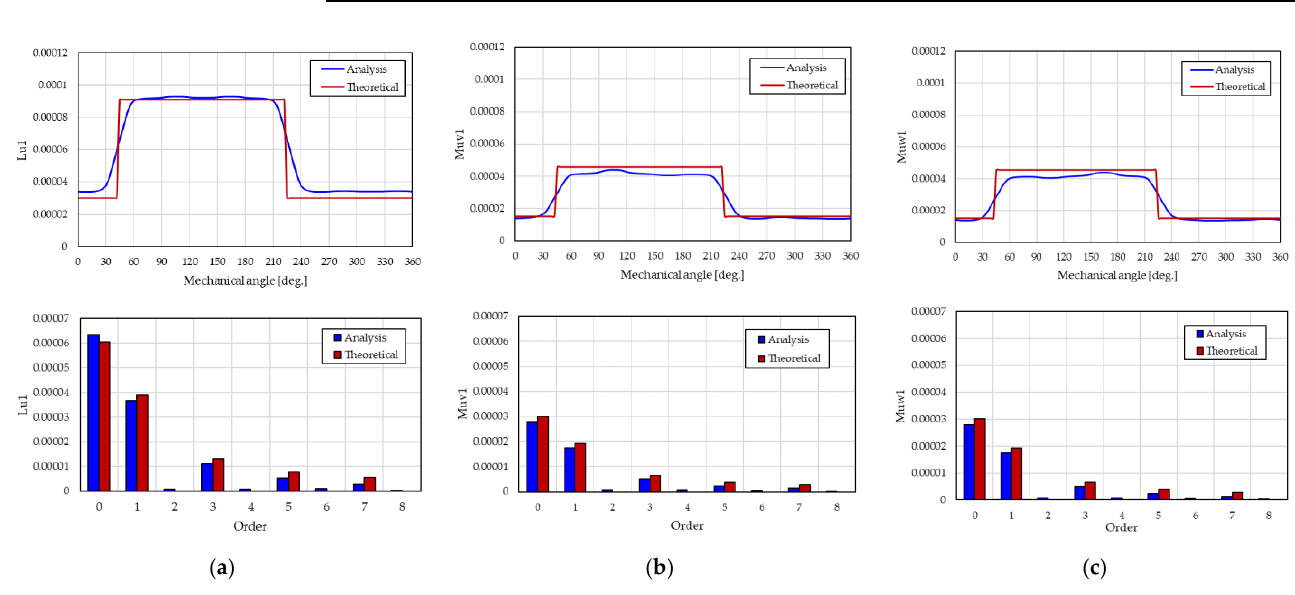
Figure 13. Comparison of inductance between analytical and theoretical value in U1-phase: ( a ) L u1 ; ( b ) M uv1 ; ( c ) M uw1 . ( b ) M uv 1 ; ( c ) M uw 1